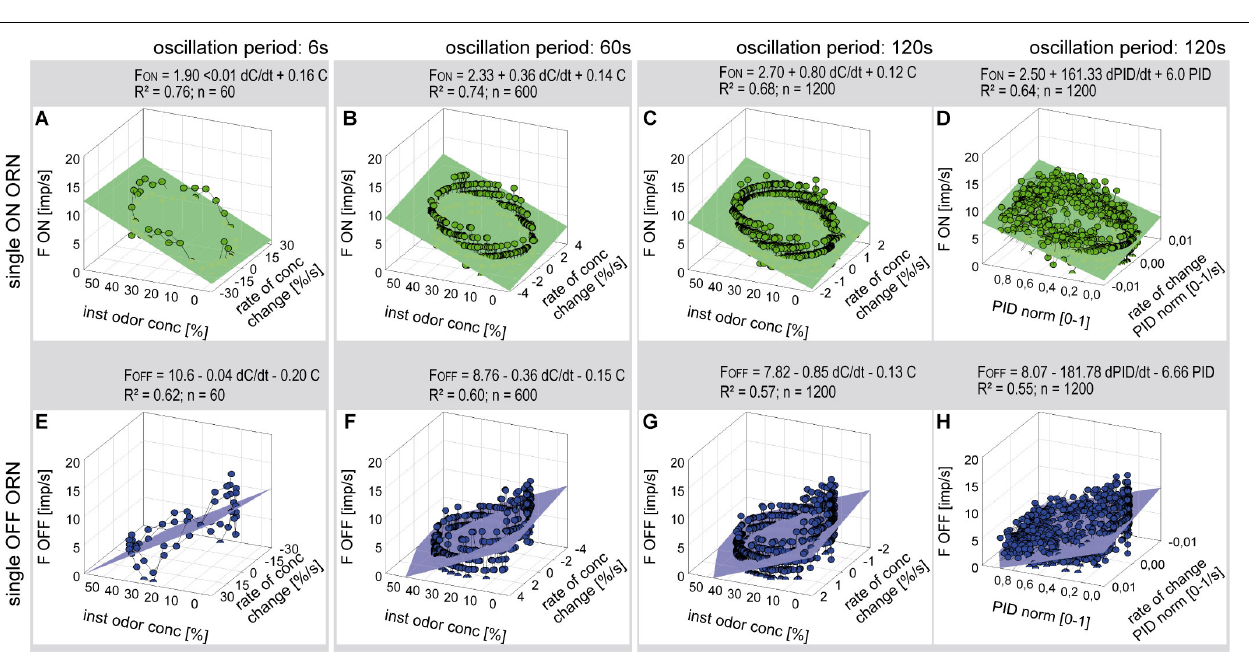
FIGURE 5 | Responses of a single ON ORN (A–D) and a single OFF ORN (E–H) during oscillating concentration changes plotted as a function of the instantaneous concentration and the rate of concentration change. Instantaneous concentration and its rate of change were measured in panels (A–C, E–G) with the flowmeter A , in panels (D,H) with the miniPID. Duration of oscillation period: 6 s in panels (A,E); 60 s in panels (B,F); 120 s in panels (C,D,G,H). Multiple regressions utilizing 3-dimensional planes F = y 0 + a d C/ d tC + b C ; where F is the impulse frequency, y 0 the height of the regression plane) were calculated to determine the gain of response for the rate of concentration change ( a slope) and the instantaneous concentration ( b slope). Note that the sign of the concentration axis in panels (A–D) is oriented in different direction than in panels (E–H). R 2 coefficient of determination, n number of points used to calculate regression plane.